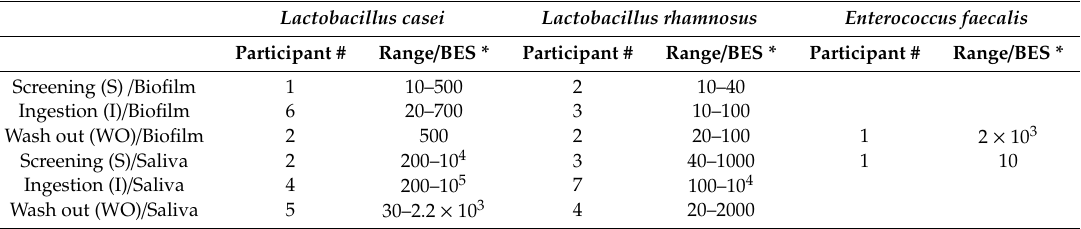
Table 2. Detected putative probiotic bacteria in biofilm and saliva samples in the di ff erent phase. Lactobacillus casei